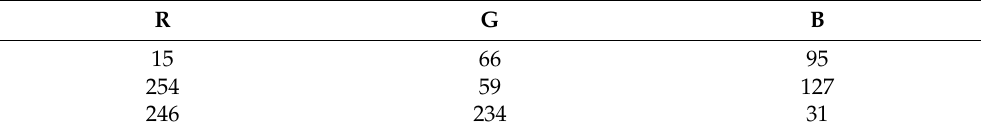
Table 2. Value of RGB channels.